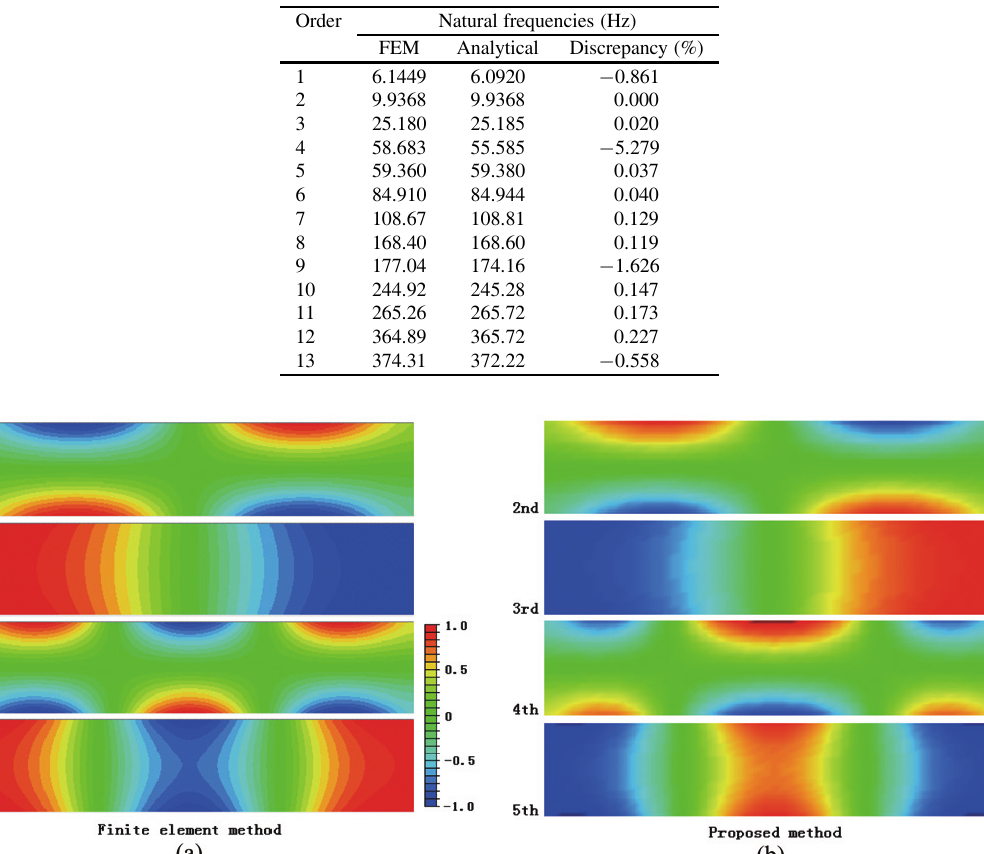
Table 1 Comparison of results by FEM and the analytical